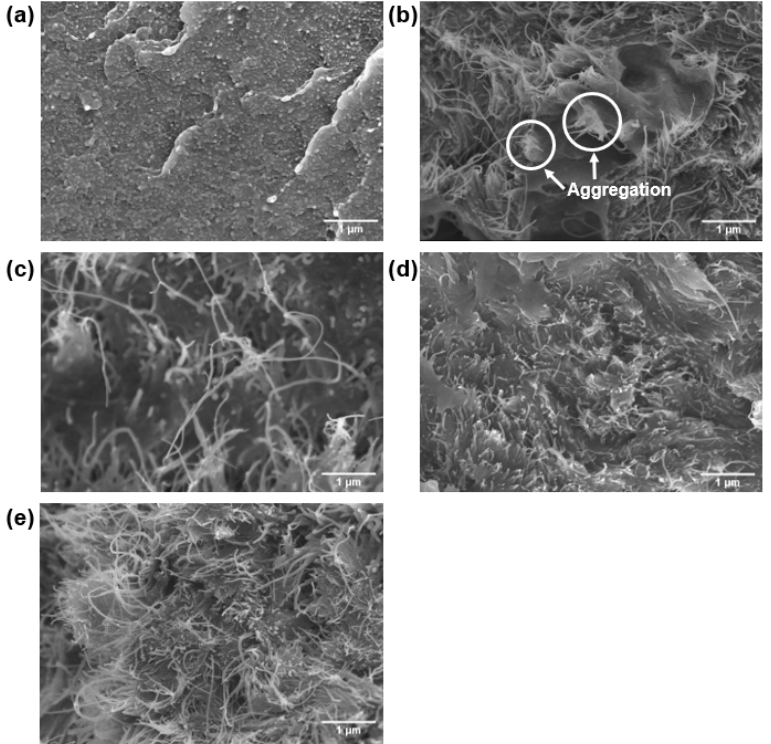
Figure 3. Field-Emission Scanning Electron Microscopy images of the PPS/MWCNTs composites. ( a ) Neat PPS, ( b ) PPSP1, ( c ) PPSA1, ( d ) PPSHP1, and ( e ) PPSS1.